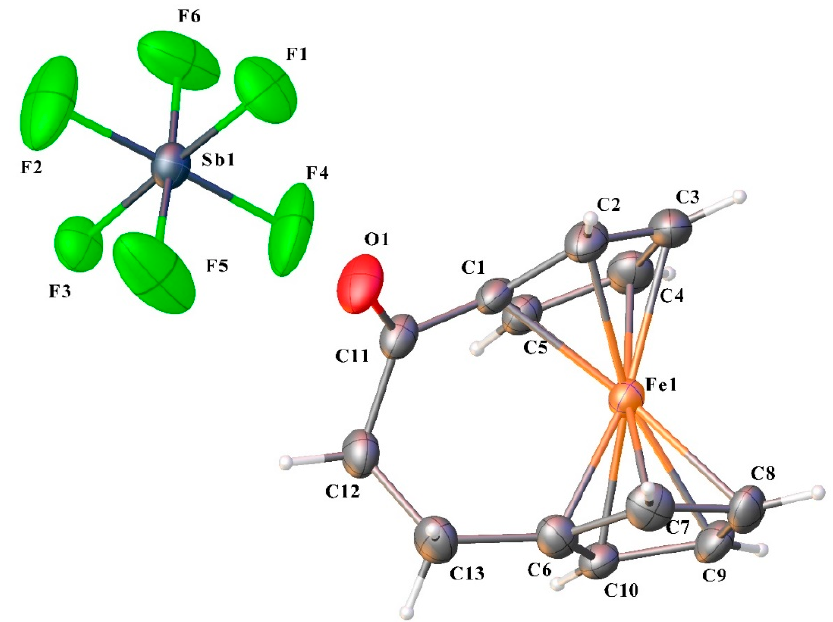
Figure 1. Molecular structure of 1 + SbF 6 showing the displacement ellipsoids drawn at 50% proba- bility level with atom labeling scheme. Key bond lengths (Å) and angles (°): C(1)-Fe(1): 2.033(10), C(6)-Fe(1): 2.026(13), C(11)-O(1):1.219(13), Cp(centroid)-Fe: 1.693; Cp-Cp angle: 14.39(6), C11-C12- C13: 111.0(11).